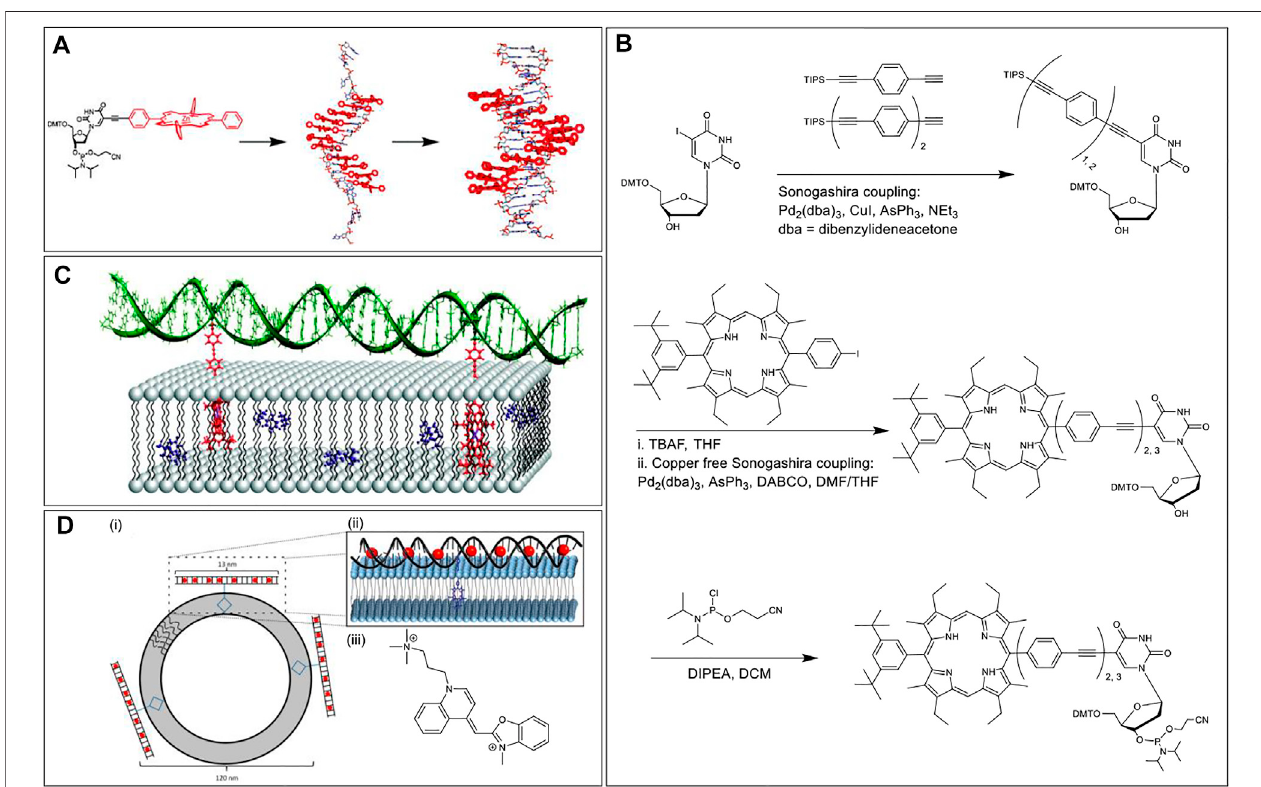
FIGURE 2 | (A) Solid-phase automated DNA synthesis using a phosphoramidite-porphyrin nucleotide (prepared via Sonogashira coupling) as building blocks offers a DNA sequence with multiple porphyrin units in a row. The porphyrin units align themselves in the major groove when the sequence is hybridized with a complementaryDNAsequence.Reprintedwithpermissionfrom(Fendtetal.,2007). (B) Synthesisoftheporphyrinnucleosidebuildingblockwith2or3repeatingunitsof phenylethynylenelinkers. (C) HybridizationofDNAonthelipidsurfaceanchoredbytwoporphyrinsembeddedinthelipidbilayer.Thelengthofthephenylethynylene linker was optimized to ensure proper assembly with the porphyrin chromophores placed inside the lipid layer and DNA duplex tangential to the membrane surface. Adaptedwithpermissionfrom(Börjessonetal.,2010). (D) (i)DuplexDNAconjugatedtoacentralporphyrinthatanchorsthesystemtolipidvesicles.(ii)Azoomed-inview ofYOdyesintercalatedintheDNAduplexandporphyrinembeddedinthelipidbilayer.(iii)ChemicalstructureoftheYOdye.Reprintedwithpermissionfrom(Wolleretal.,